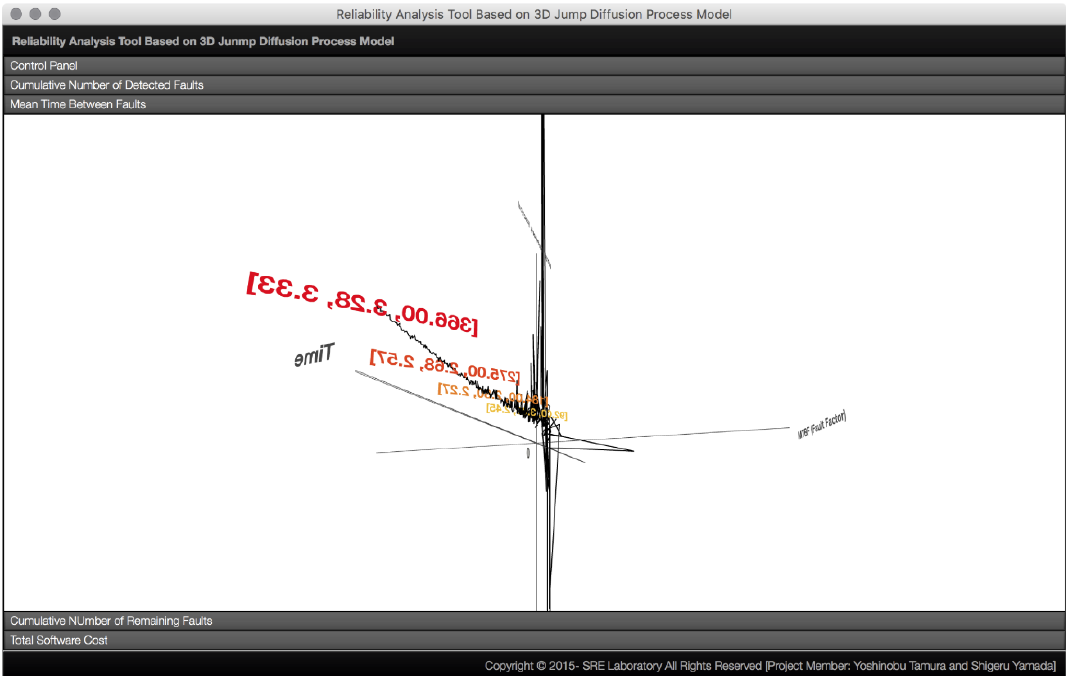
Fig. 3. The sample path of the mean time between software